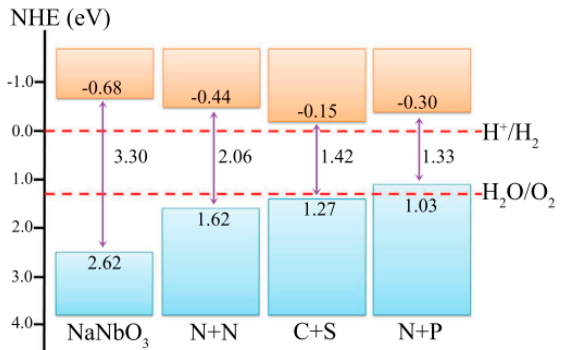
Figure 6. Band edge positions of the pure and codoped NaNbO 3 . Reproduced with permission from the authors of [45]. Copyright (2019), John Wiley & Sons, Inc., Hoboken, NJ, USA. NHE, normal hydrogen electrode.